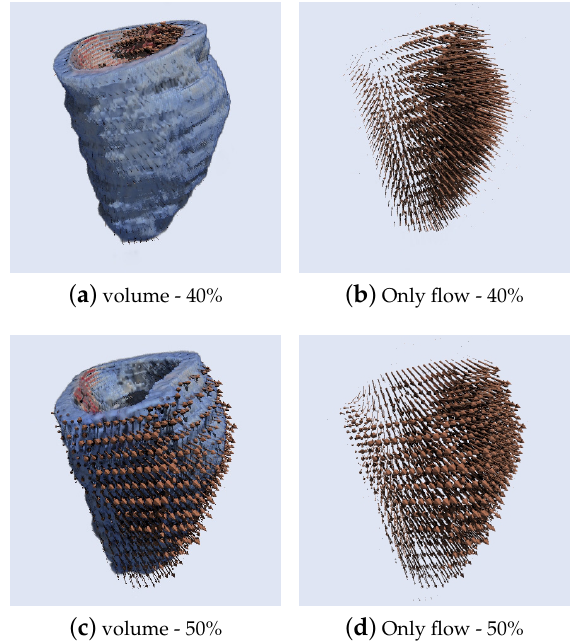
Figure 22. Results of 3D Optical Flow of a segmented cardiac CT volume (left ventricle) computed at phases 40–50% (relaxation